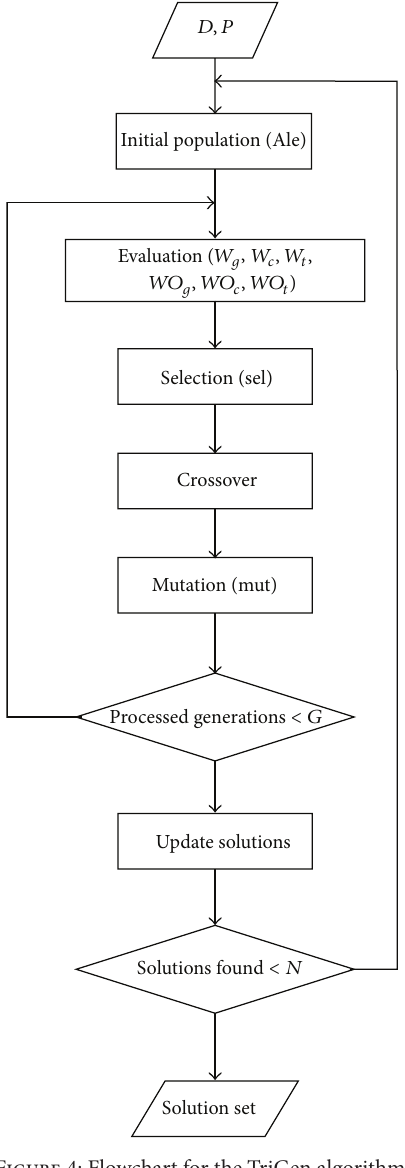
Figure 4: Flowchart for the TriGen algorithm.